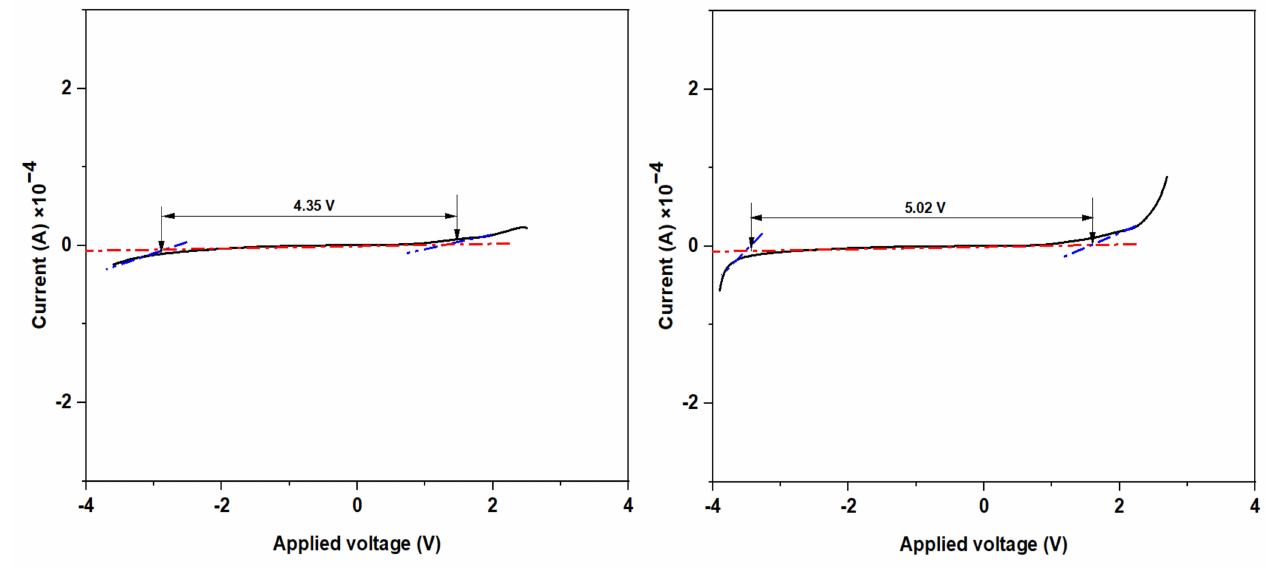
Figure 10. LSV curves of MPK20 and MPKE15 SPE.